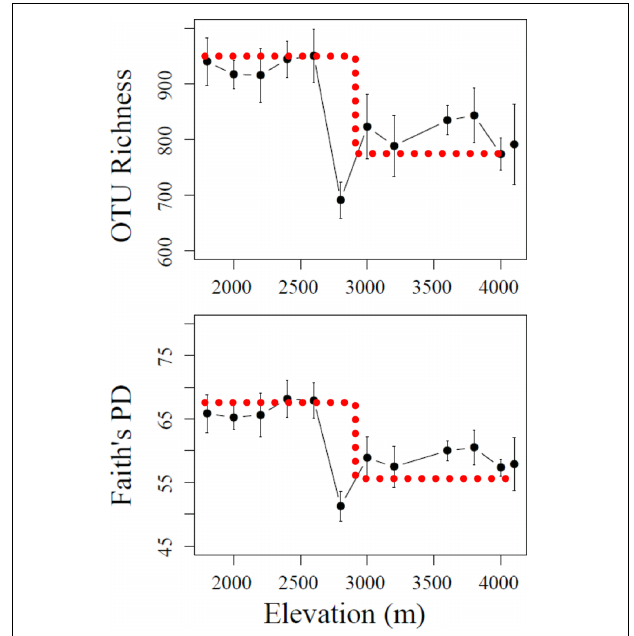
FIGURE 1 | Stair-step patterns of α -diversity indices including OTU richness and Faith’s PD across the elevational gradients. The bar represents standard deviation (SD). The dotted line denotes a “stair-step”